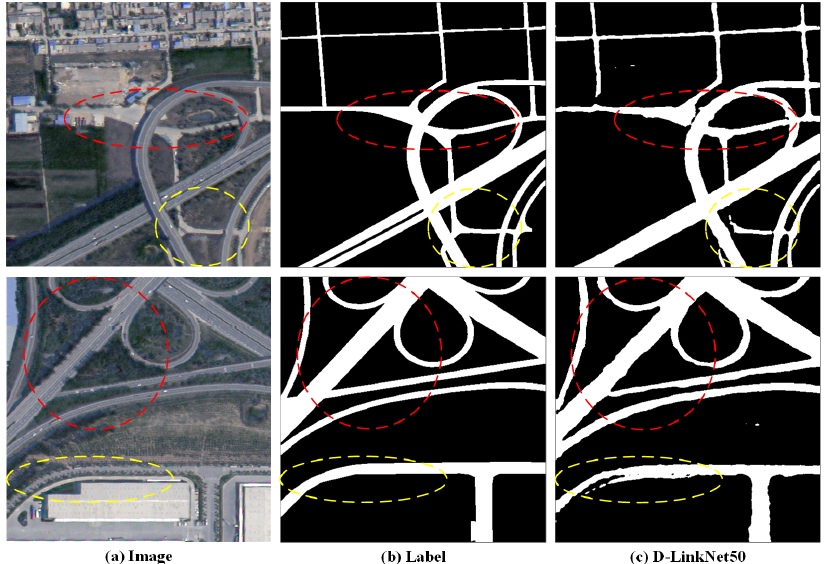
Figure 1. Roads extracted using existing methods are discontinuous and jagged at the bound- ary, especially when the roads are narrow, as shown in the yellow and red circles, respectively. Columns ( a – c ) represent sample images, corresponding labels, and results extracted by D-LinkNet50,